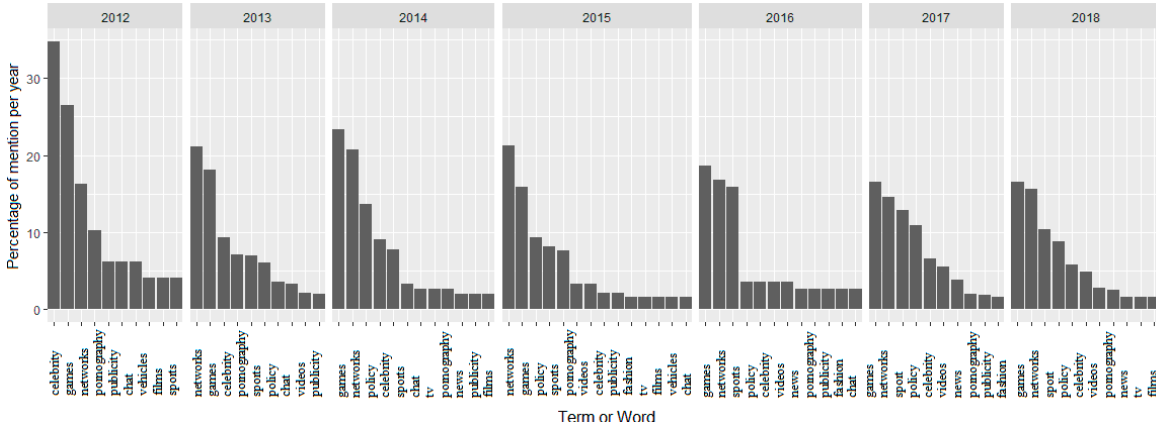
Figure 1. Frequency of mention of the word or related terms (per year) in response to the following question: What topics are you interested in seeing and consuming on the Internet?